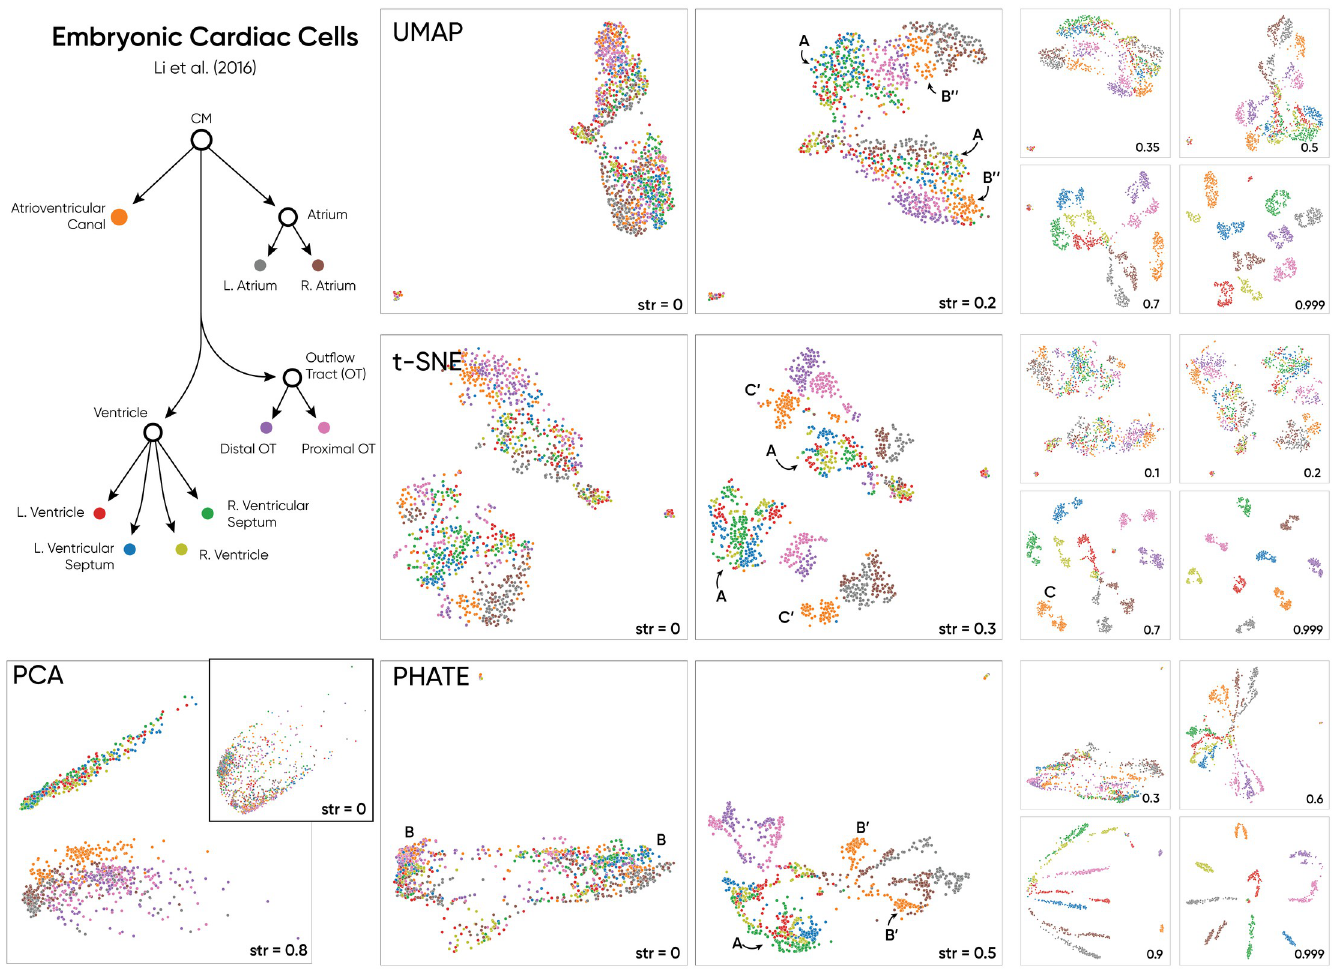
Fig 3. Haisu applied to anatomical embryonic cardiac cell subpopulations via a proximity-based hierarchy. The raw embeddings of each method indicate two primary clusters with cell label assignments that are spaced out within each cluster. Haisu helps to add clarity to the embedding in a manner true to the known external hierarchy. Labels are assumed to be 100% accurate as they are location-based, but anatomic regions can have similar transcriptomic profiles. Thus, Haisu in this context, factors in gene expression and location when determining a lower dimensional embedding at an appropriate